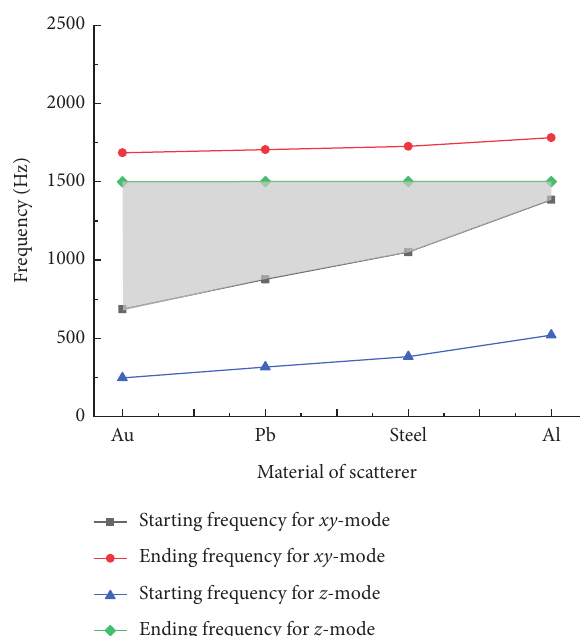
Figure 5: Effect of scatterer density on boundary frequencies of the 1st complete band gaps.